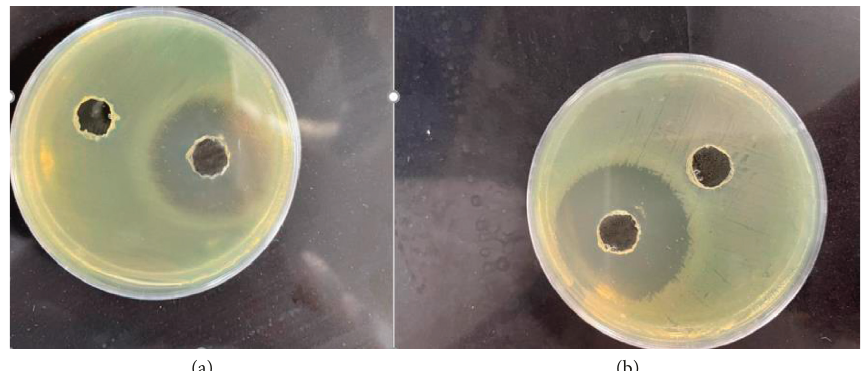
Figure 8: (a) Standard strain (left picture) showed more susceptibility to biosynthesized SeNPs; (b) also, the right picture is isolated strain.